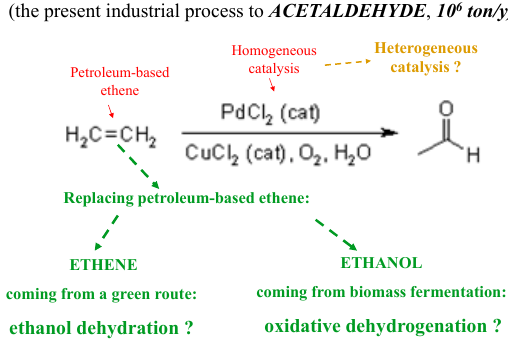
Figure 2. Potential green alternative to the Wacker oxidation.